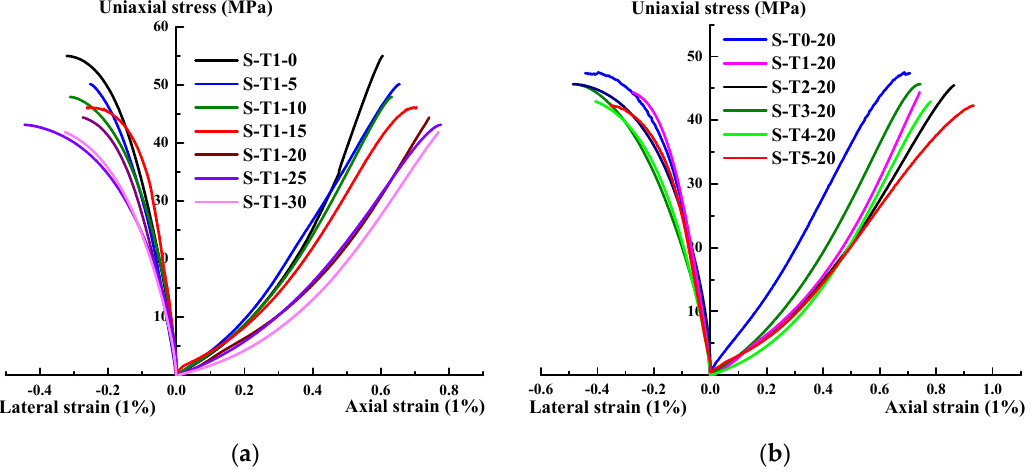
Figure 8. Stress–strain curves of sandstone samples: ( a ) with different freeze–thaw cycles ( T = − 20 °C); ( b ) with different freeze–thaw temperatures ( N = 20).